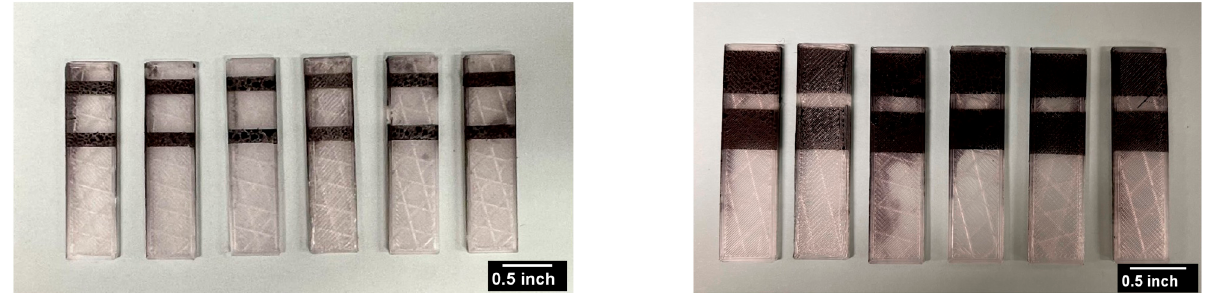
Figure 3. The RF coupons with varying surface coverages of the graphite. The coupons’ dimensions are 50.8 mm × 12.7 mm (2 ″ × 0.5 ″ ). are 50.8 mm × 12.7 mm (2 (cid:48)(cid:48) × 0.5 (cid:48)(cid:48)